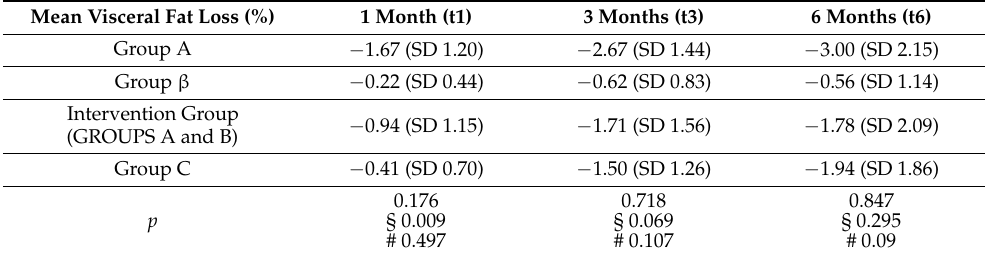
Table 5. Mean visceral fat mass loss expressed in %. Results are expressed as mean values of groups A (high dosage—15 mg HT/day), B (low dosage—5 mg HT/day) and C (placebo) for time points T1, T3 and T6. The p -value express statistical differences between the intervention and placebo groups. # marker is used for comparisons between groups B and C and § for comparisons between groups A and C. SD: standard deviation.